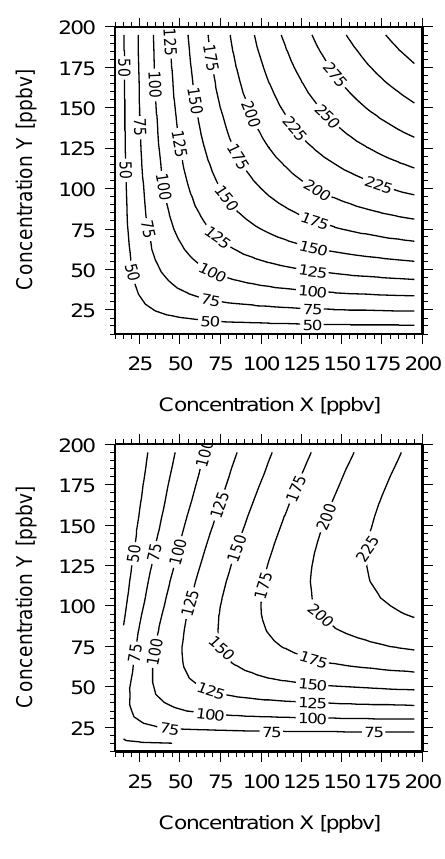
Fig. 2. Equilibrium concentrations for species Z (top) and ˜ Z (bot- tom) [ppbv] as a function of the concentrations of X and Y.